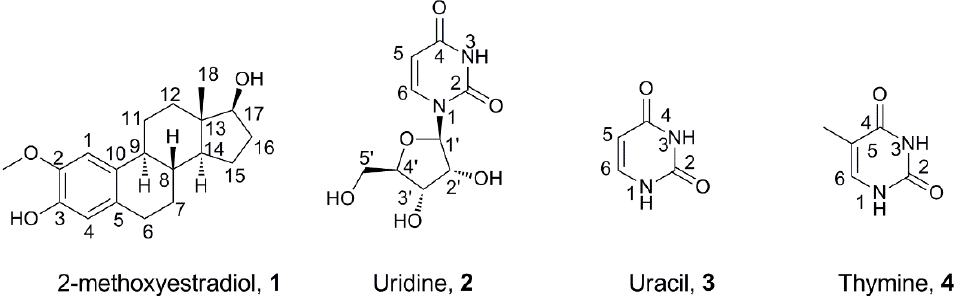
Figure 1. Chemical structures of 2-methoxyestradiol, uridine, uracil, and thymine.